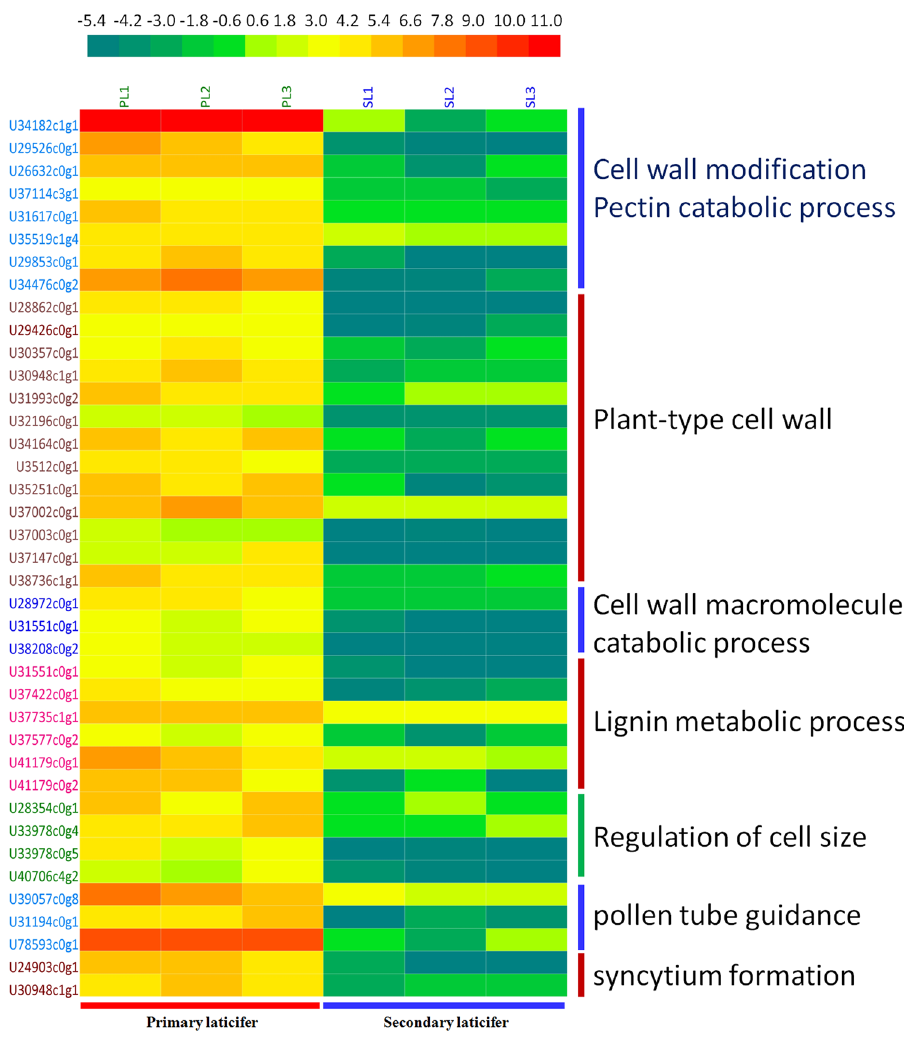
Figure 4. Heatmap of DEGs involved in cell growth and cell wall modification. The expression levels of DEGs in TPM were compiled with Excel 2007, normalized using a log2 base method, and exported to the HemI toolkit 124 . The Heatmap was generated using the default parameters. The expression levels are presented as different colors, and the values are defined in the scale bar. PL, the primary laticifers; SL, the secondary